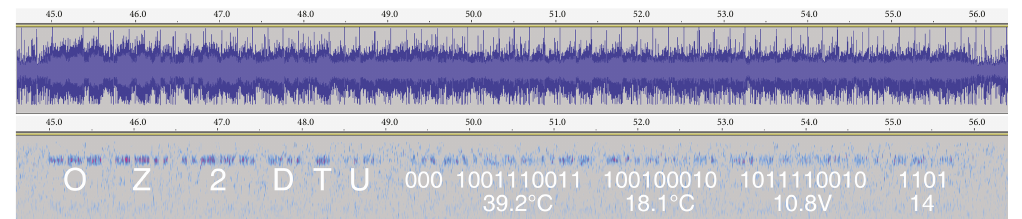
Figure 5: An example of a COM beacon recorded on 20 th May 2015. The top image shows a noisy signal. Lower image show the pitch in the signal and the decoded signal. Despite the noise the human ear may pick out the signal showing the strength of the Morse